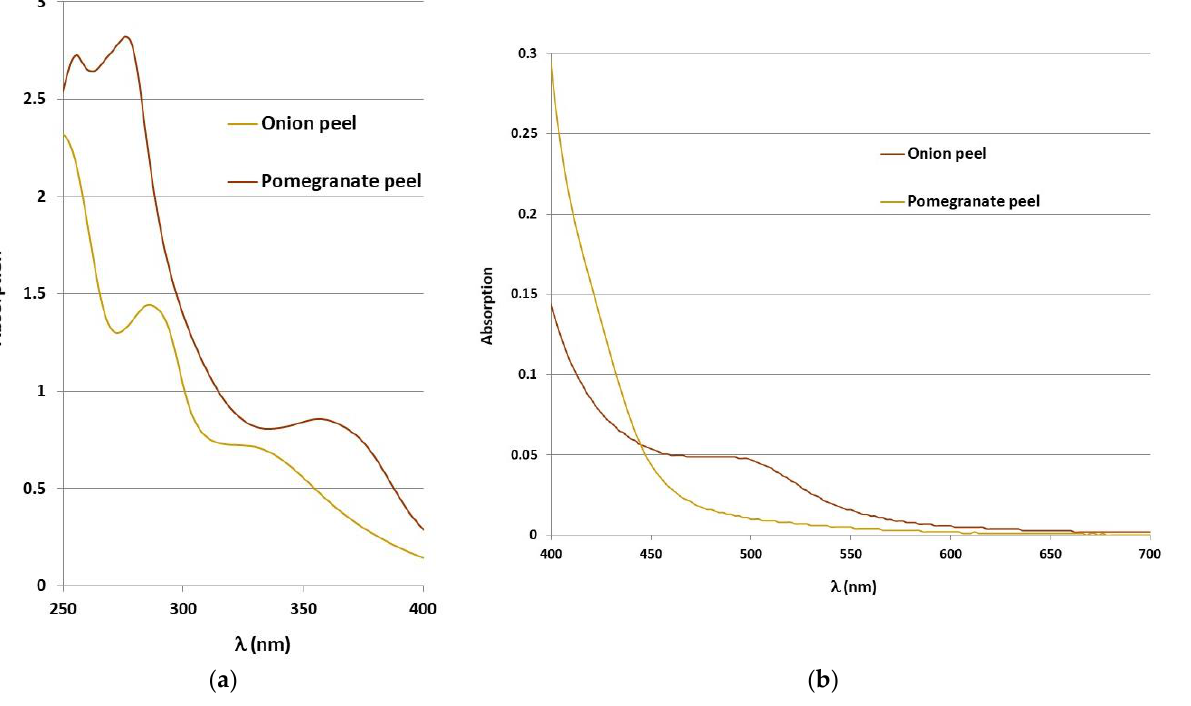
Figure 2. Absorption spectra of onion and pomegranate extracts in the ( a ) ultraviolet part and ( b ) visible part of the spectrum. ( b ) visible part of the